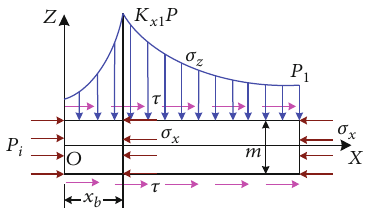
Figure 7: Stress analysis model of the edge coal – rock